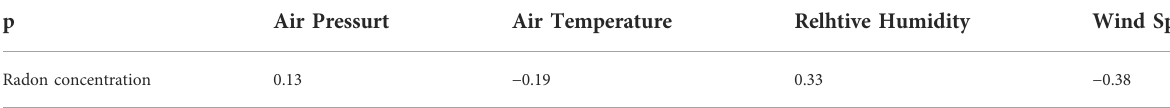
TABLE 1 Correlation coef fi cient between radon concentration and meteorological parameters.